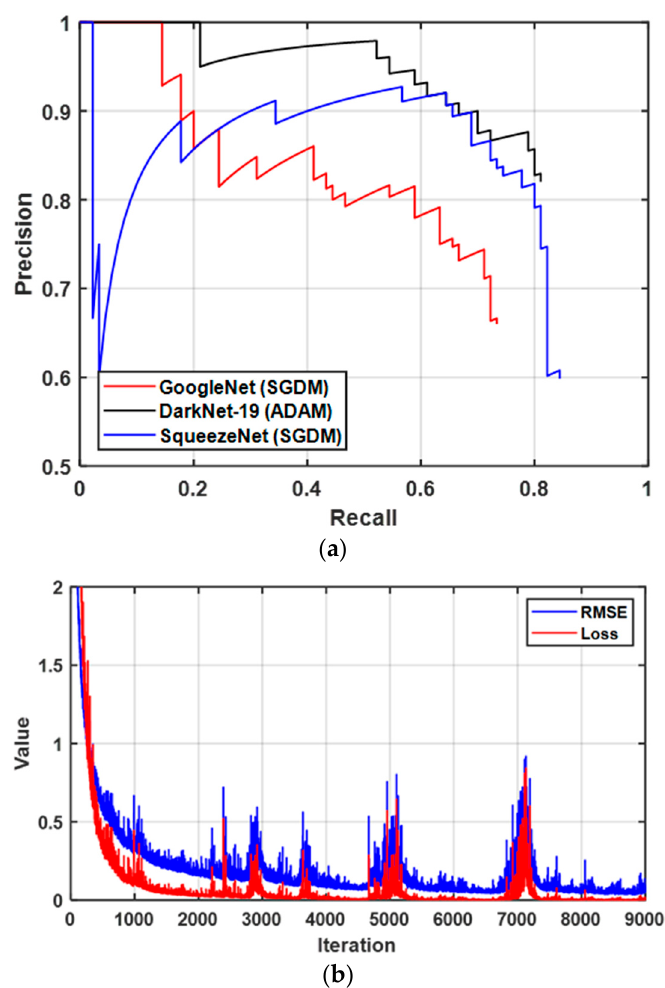
Figure 11. ( a ) Precision–recall curves at a 0.5 of threshold and ( b ) training RMSE and loss curves for DarkNet-19 network and ADAM optimizer.